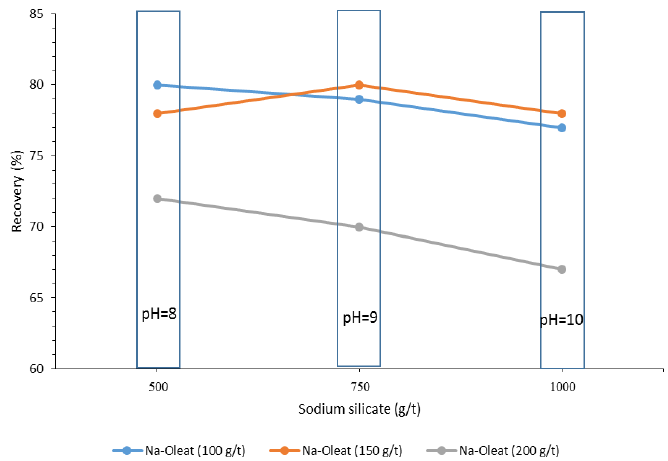
Figure 10. Effect of sodium silicate dosage on the recovery of the boron minerals